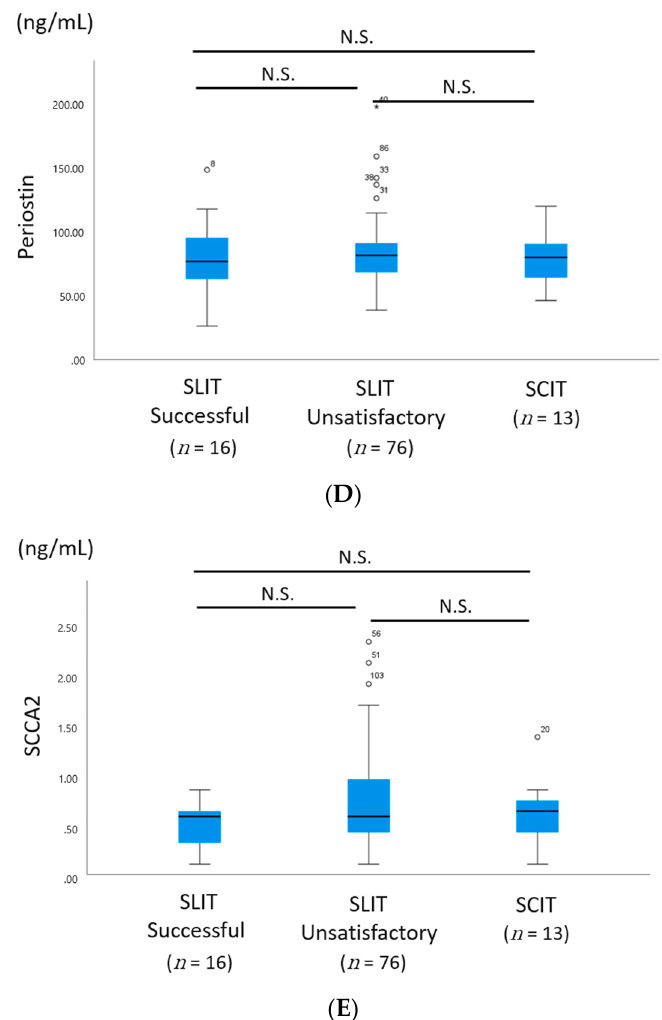
Figure 1. Serum concentrations of JCP-specific IgE ( A ), IgG ( B ), IgG4 ( C ), periostin ( D ), and SCCA2 ( E ). * p < 0.05, N.S.: not significant (Mann–Whitney U test).